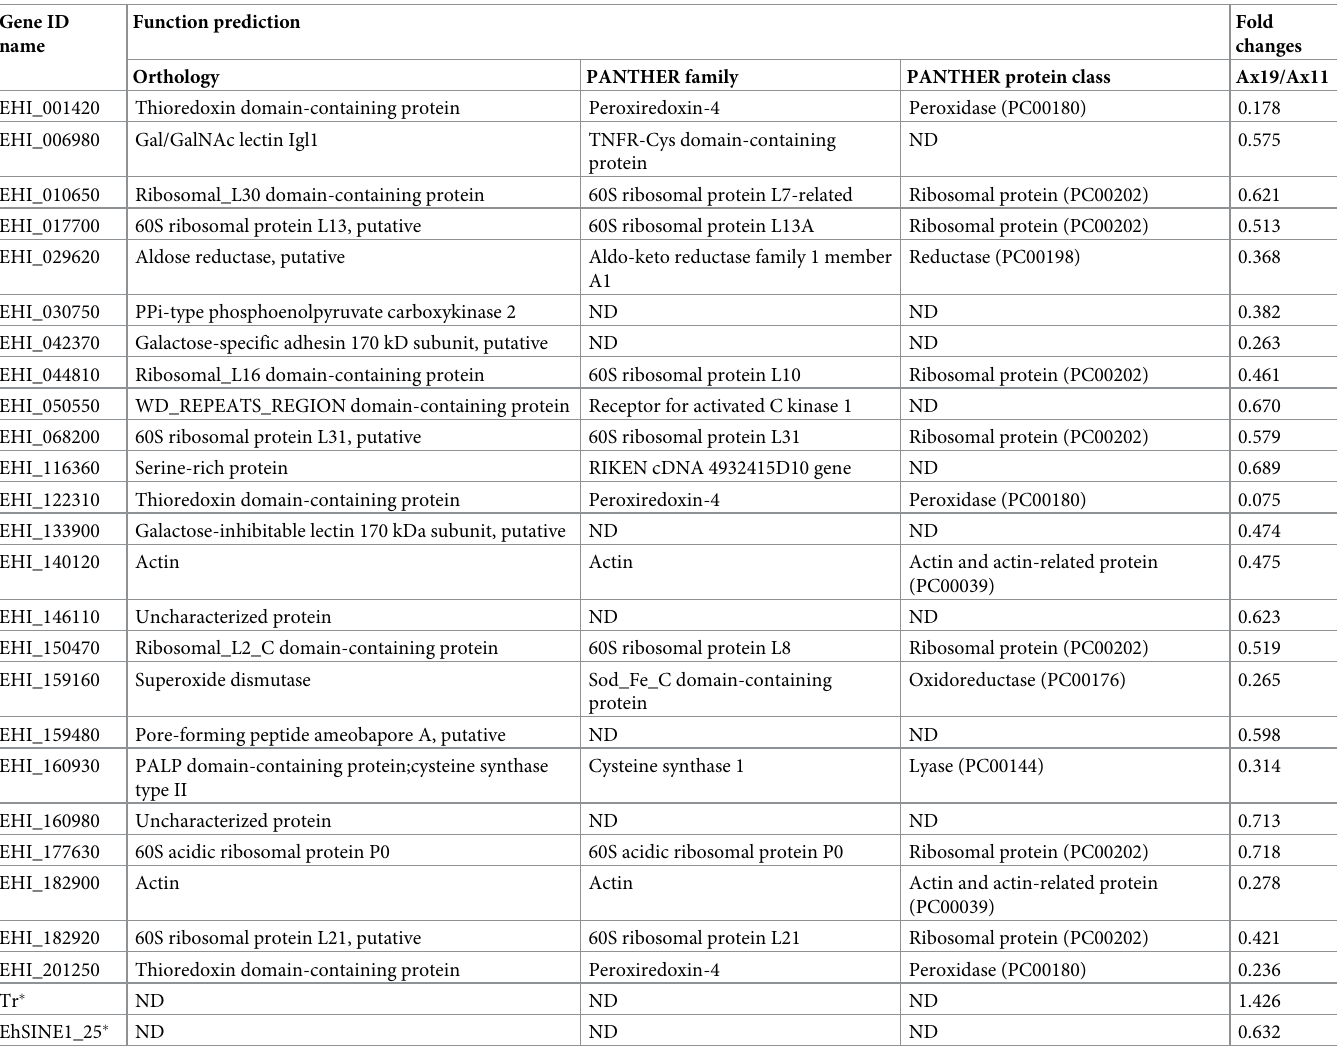
Table 2. Orthologous lists of the 26 differentially expressed genes that were oppositely up- or down-regulated between Ax19 (liver abscess strain) and Ax11 (asymp- tomatic